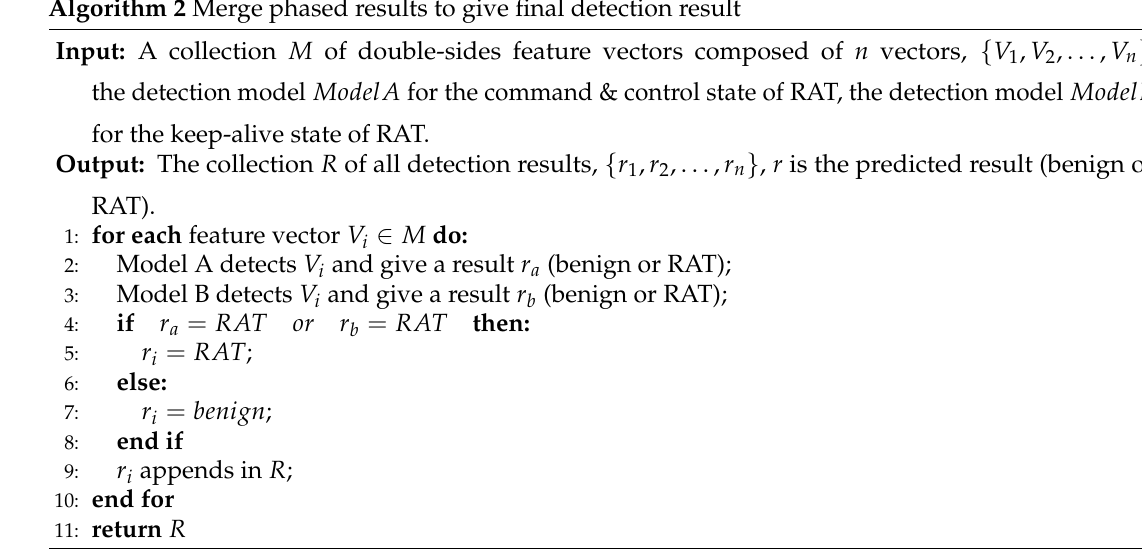
Algorithm 2 Merge phased results to give final detection